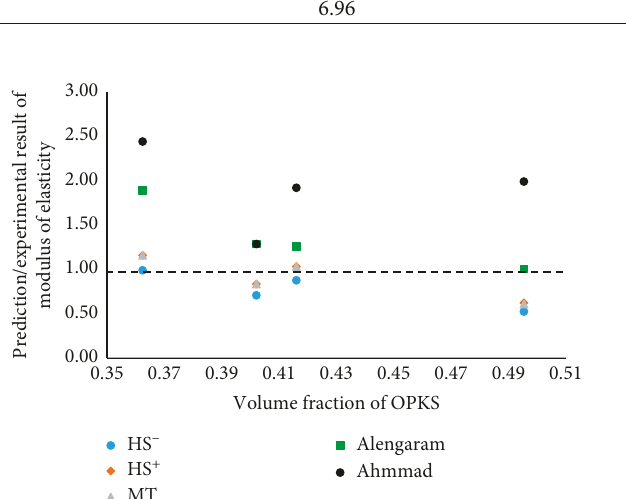
Figure 10: Variation in the ratio of the predicted to the experimental MoE values according to the volume fraction of